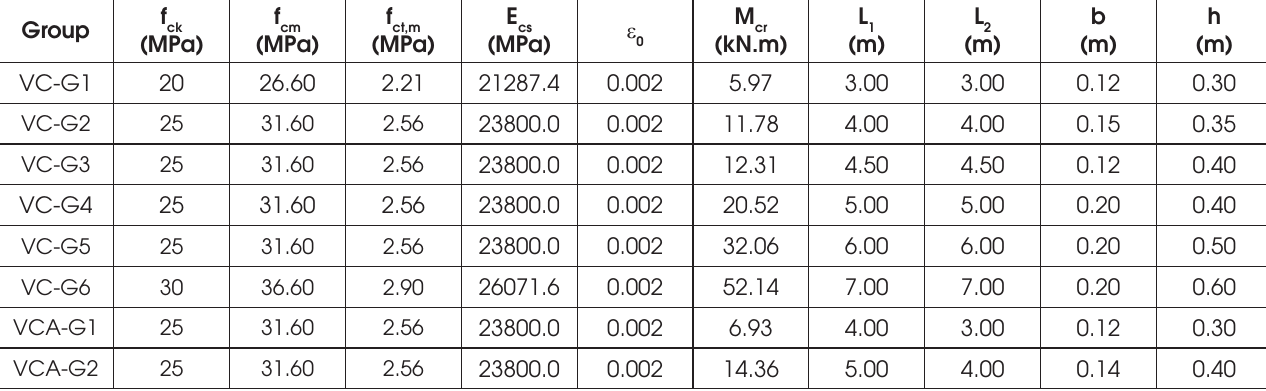
Concrete properties, cracking moment and geometry for the groups of two-span